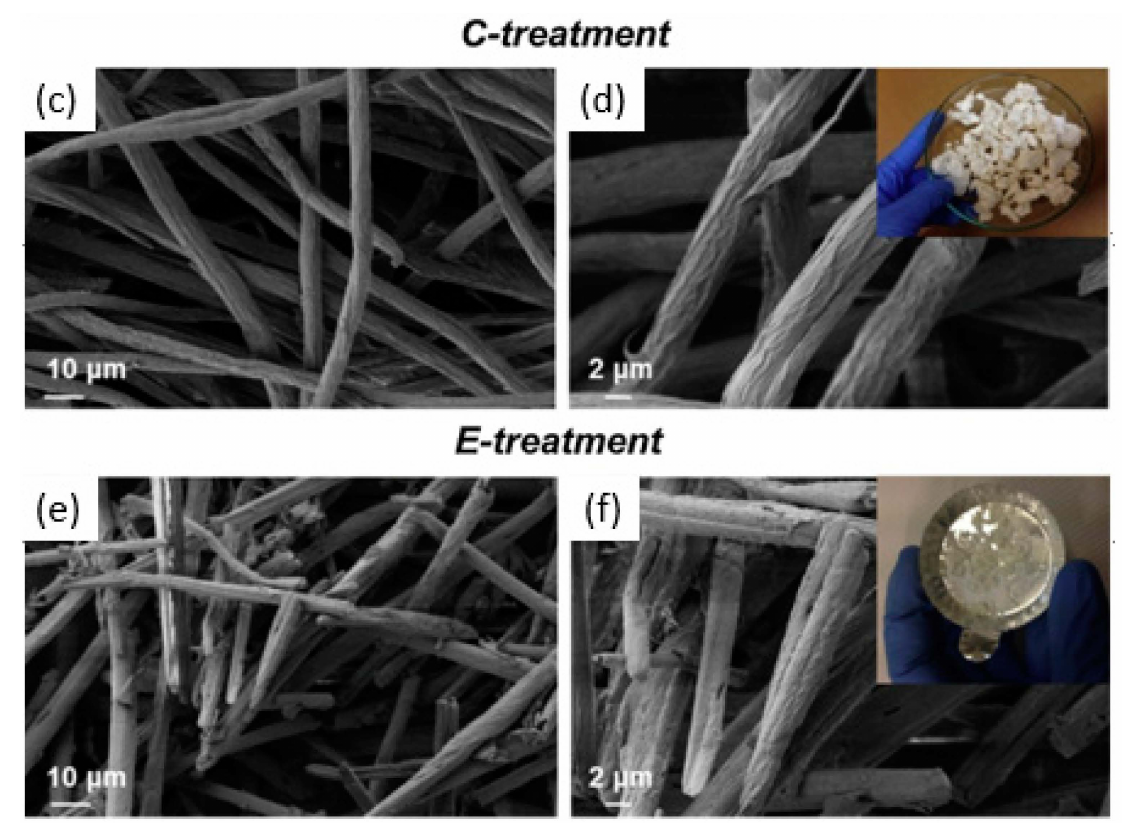
Figure 3. Morphological characterization of Diss fibers: longitudinal ( a ) and transversal section ( b ). FESEM investigation of bleached fibers using chemical ( c , d ) and enzymatic ( e , f ) treatment at two different magnifications. The visual image of treated fibers: insert ( d ) chemically treated fibers and insert ( f ) enzymatically treated fibers. Reproduced from [60].